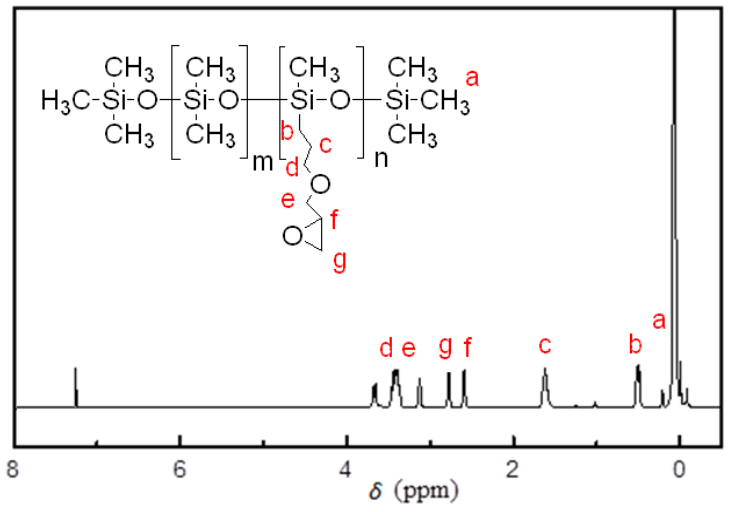
Figure 1. FTIR spectra of ( a ) H-PDMS and EP-PDMS; ( b ) P-G01, P-G05, and P-(G01 + G05); ( c ) G-SP-G01, G-SP-G05, and G-SP-(G01 + G05).